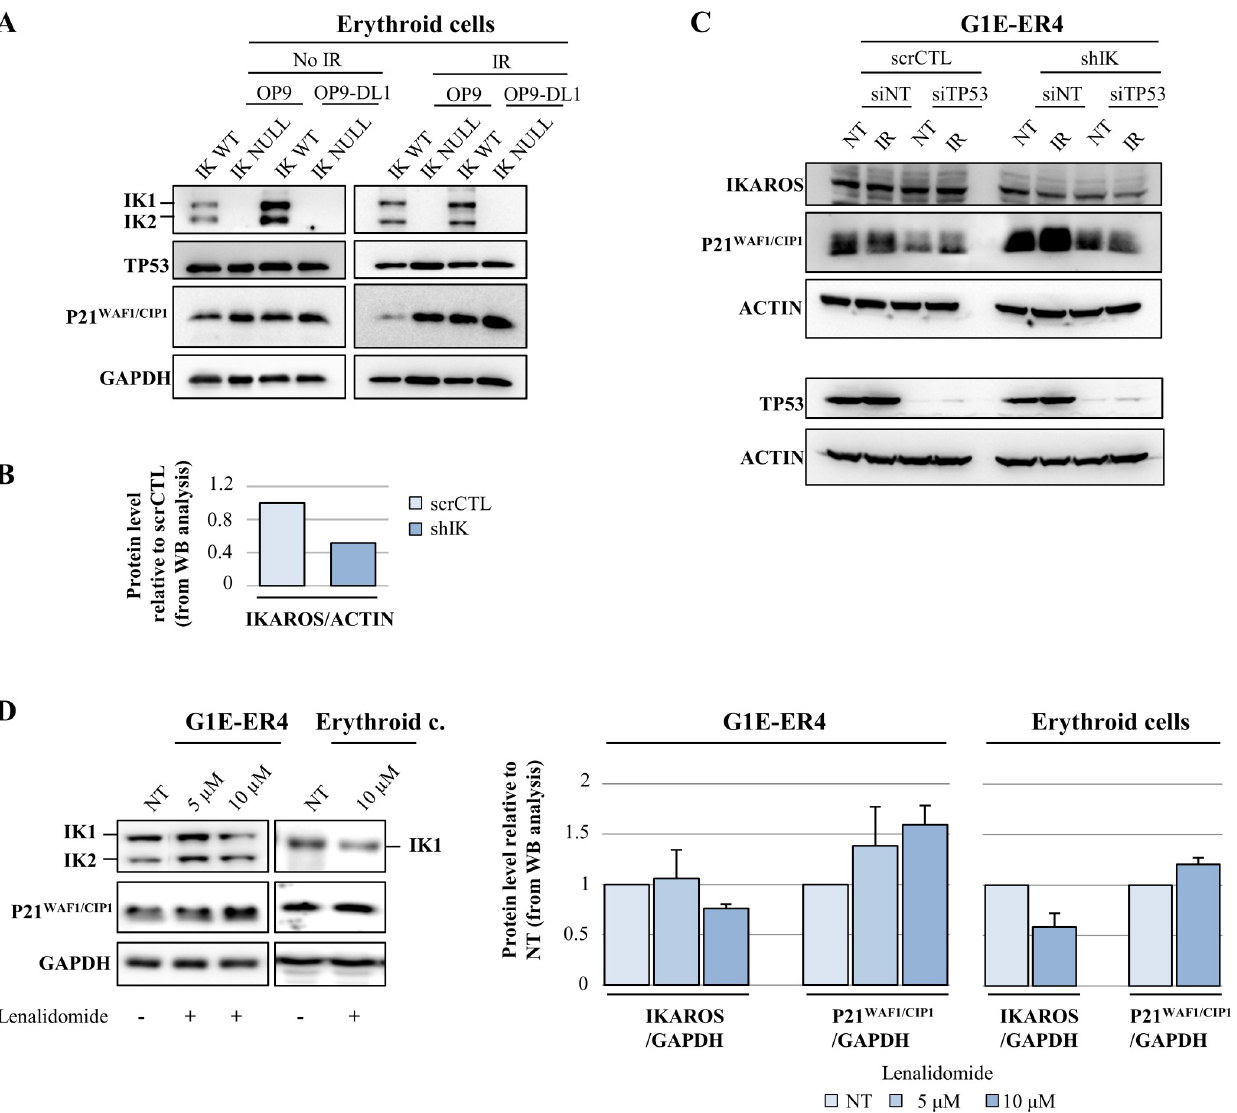
Fig 8. IKAROS is required to prevent the overexpression of P21 WAF1/CIP1 upon DNA damage induction. Western blot analyses of IKAROS, TP53, P21 WAF1/CIP1 and GAPDH or ACTIN (loading controls) expression in total cell lysates. All experiments were performed in triplicate and representative results are shown in panels A-D. (A) Ik WT or Ik Null Ter119 + cells were harvested after 48h of co-culture with OP9 or OP9-DL1 cells, irradiated (3.5 Gy) and collected 3h post-irradiation. (B) Protein expression; the relative expression levels of IKAROS in G1E-ER4 cells stably transfected with either scrCTL (non- target control) or shIK (IKAROS shRNA), were obtained by dividing the densitometric values (calculated using the Multi Gauge V3.0 software; right panel) of IKAROS bands by the values of ACTIN bands (IK/ACTIN ratios); y axis: IKAROS/ACTIN protein level in shIK relative to scrCTL. (C) G1E-ER4 cells transfected either with scrCTL (non-target control) or shIK (IKAROS shRNA); stable clones were transiently transfected with either siNT (control) or siTP53 and irradiated (3.5 Gy); cells were collected 3h post-irradiation. (D) G1E-ER4 or erythroid cells were treated with 5 μ M or 10 μ M lenalidomide; cells were collected 24h after the treatment; the relative expression levels were obtained dividing the densitometric values (calculated using the Multi Gauge V3.0 software) of IKAROS bands by the values of GAPDH bands (IK/GAPDH ratios) or P21 WAF1/CIP1 bands by the value of GAPDH bands (P21 WAF1/CIP1 / GAPDH ratios); relative expression levels are represented by bars and plotted as the mean ± Standard Deviation of the measurements (right panel); � : p � 0.05 by Student’s t-test; IK1: IKAROS splicing isoform 1; IK2: IKAROS splicing isoform 2. or multiple myeloma [93,94]. As presented in Fig 8D, lenalidomide treatment of our erythroid cell models (G1E-ER4 and erythroid cells) led to IKAROS depletion and P21 WAF1/CIP1 overex- pression, suggesting that the induction of apoptosis imposed by lenalidomide treatment of